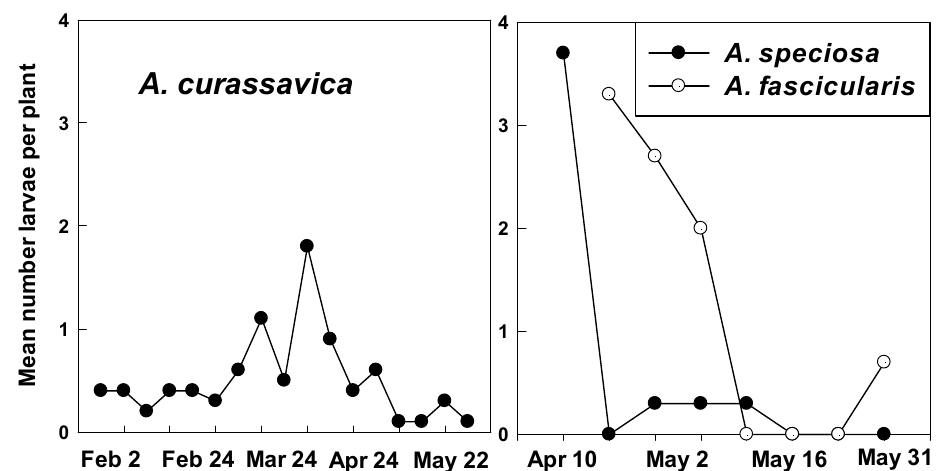
Figure 6. Monarch larvae recorded weekly on tropical milkweed ( A. curassavica ) (2 February–May 31) and native milkweeds, A. speciosa and A. fascicularis (10 April–May 31) at Googleplex, Mountain View, CA, USA.